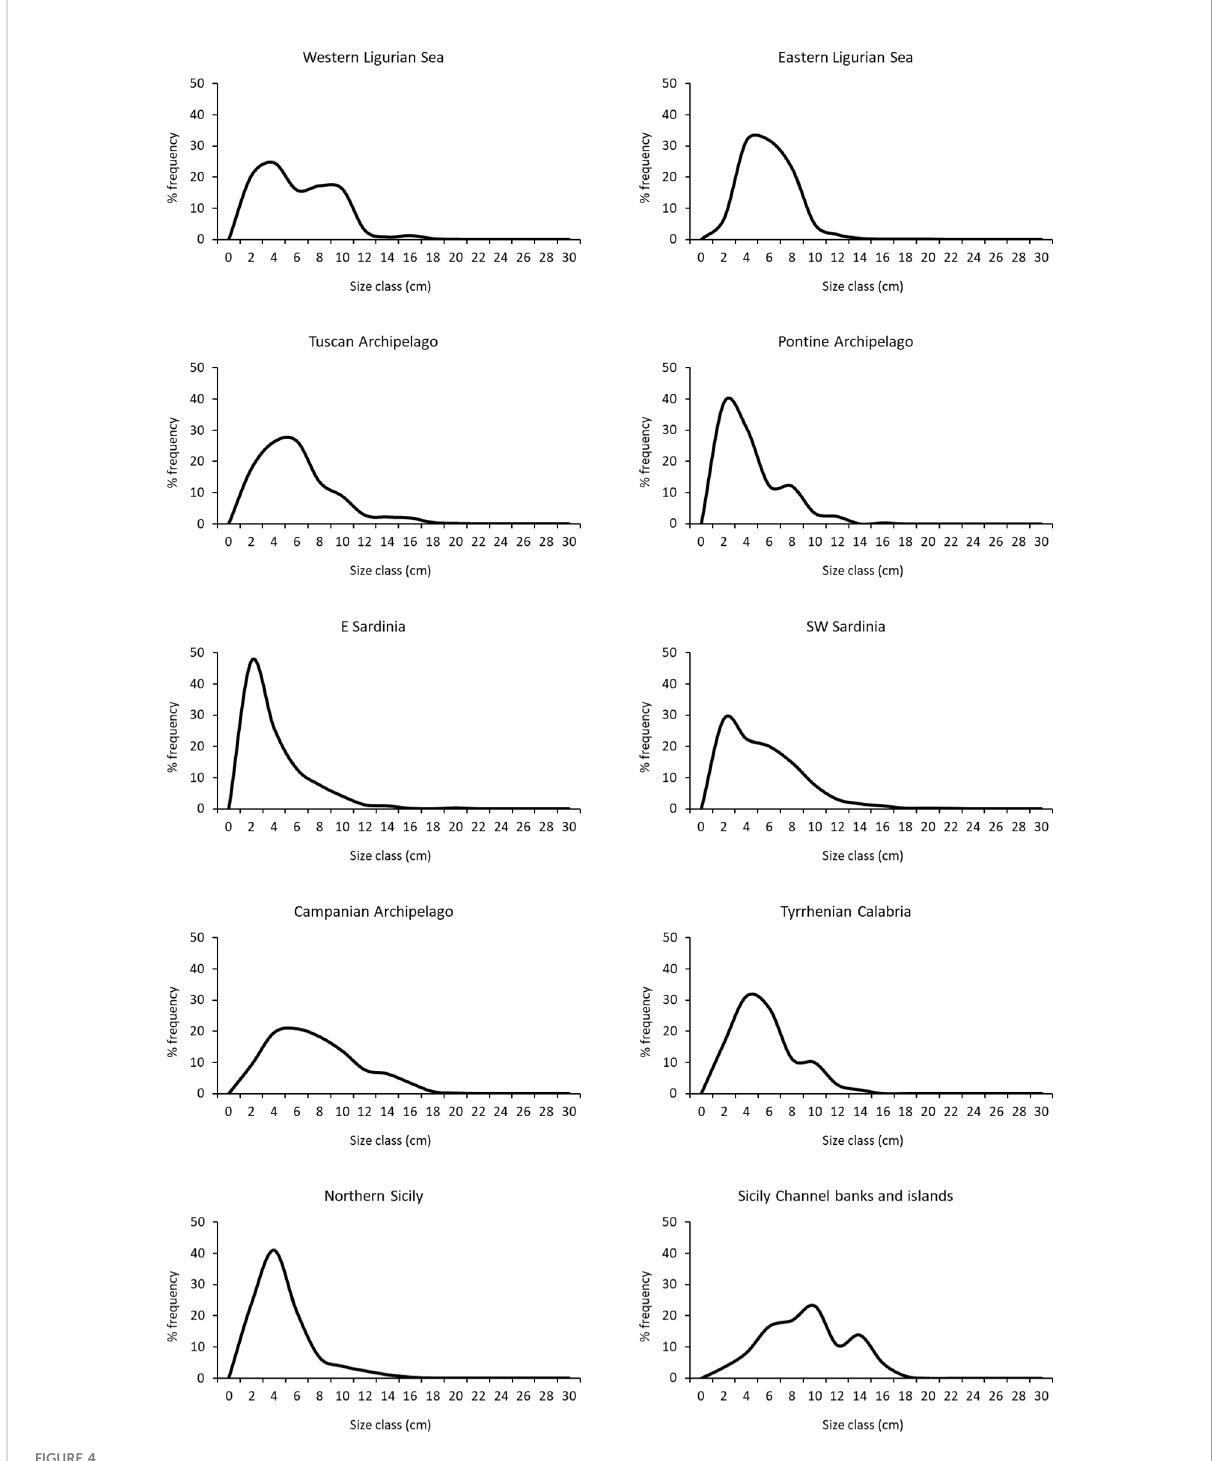
FIGURE 4 Size-frequency distribution of the populations in the coral